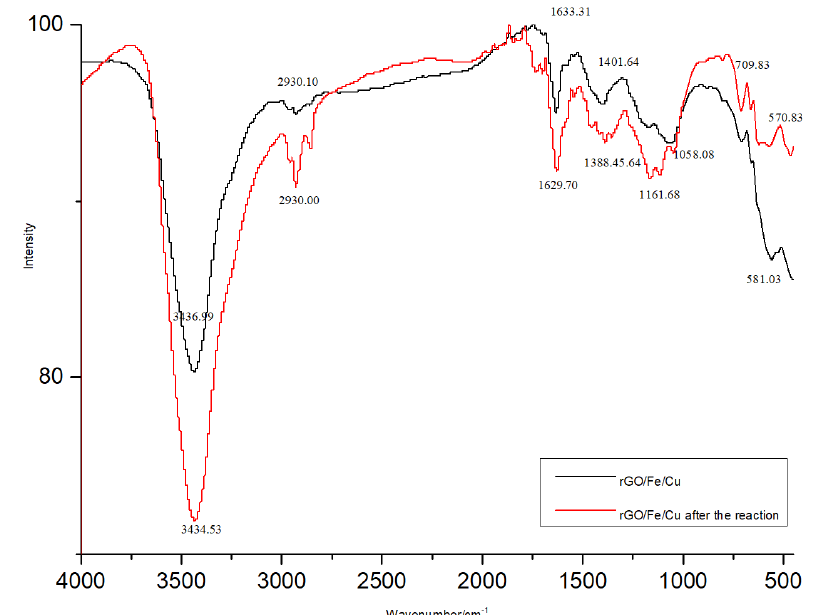
Figure 8. FTIR spectra of rGO/Fe/Cu nanocompounds before and after the reaction.